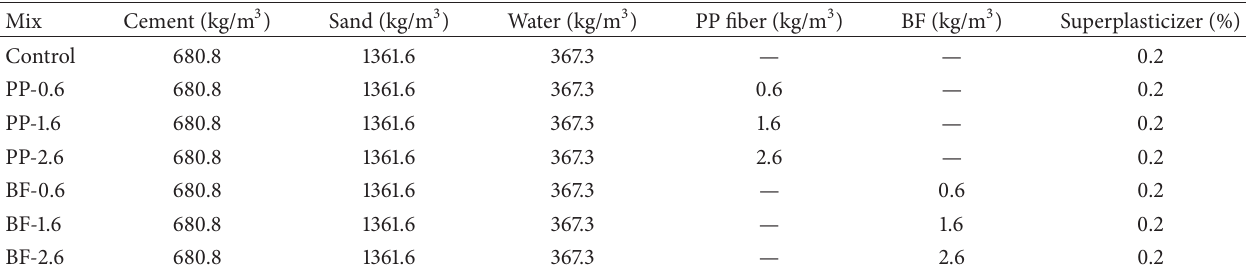
Table 4: Mix proportions of the